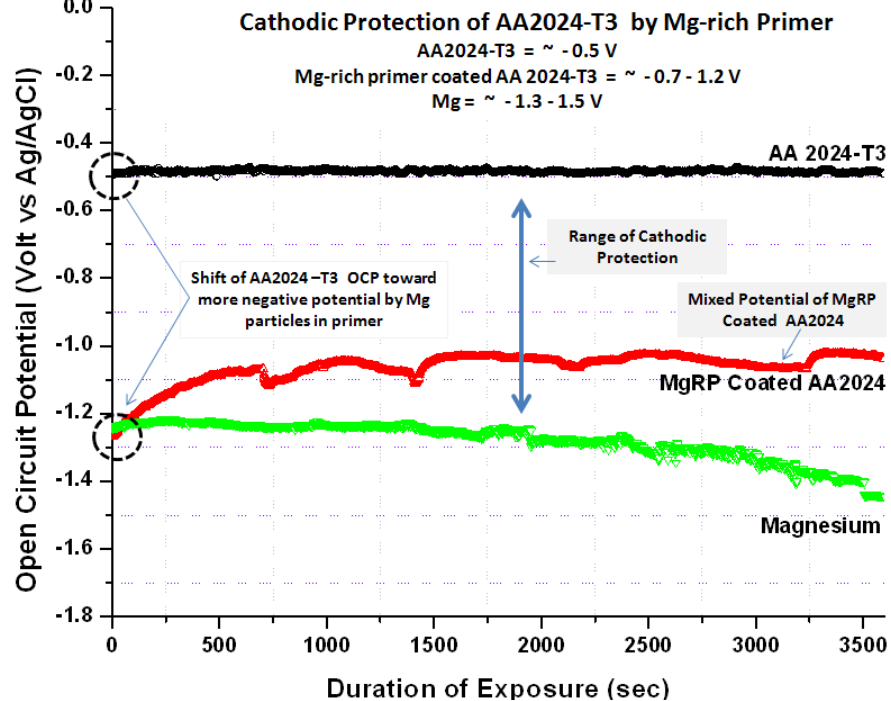
Figure 4. Open circuit potential of Mg-rich primer coated AA2024T3, bare AA2024 T3, and bare Mg in 3.5 wt % NaCl solution